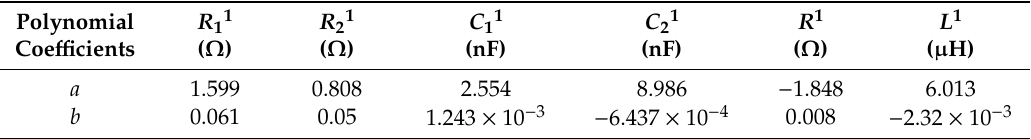
Table 7. Linear parameters for MT4 pi-circuit as a function of soil resistivity.